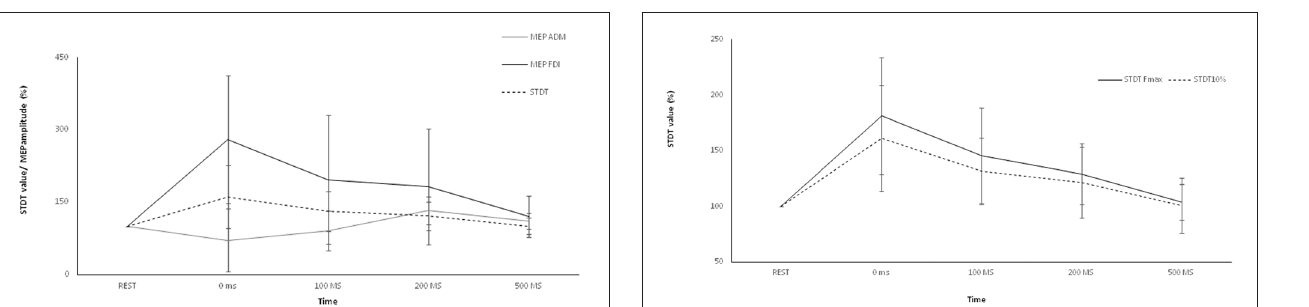
TABLE 1 | Coefficient of variation.